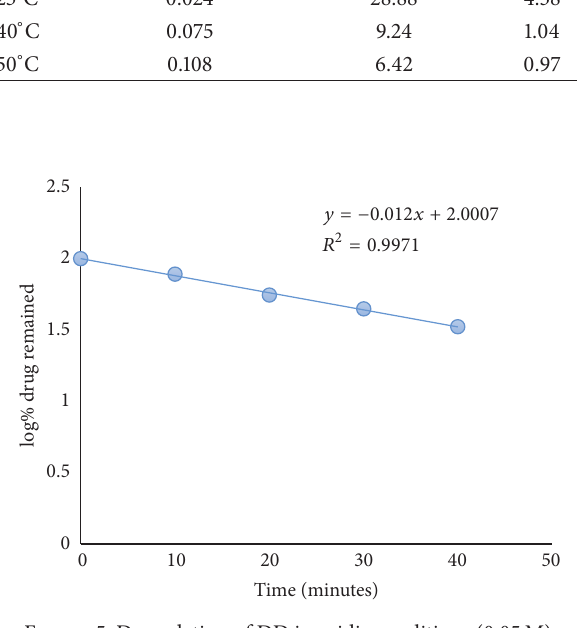
Figure 5: Degradation of DD in acidic conditions (0.05 M).